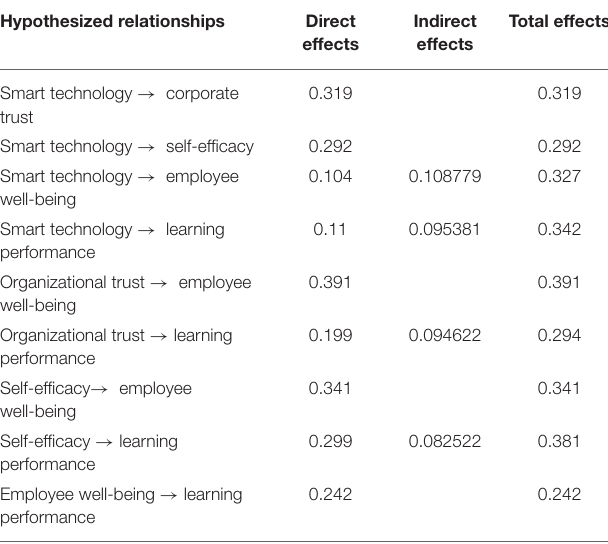
TABLE 3 | Hypothesis